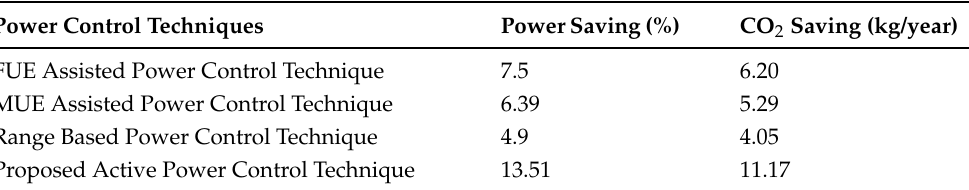
Table 3. Green Impact Calculation and CO 2